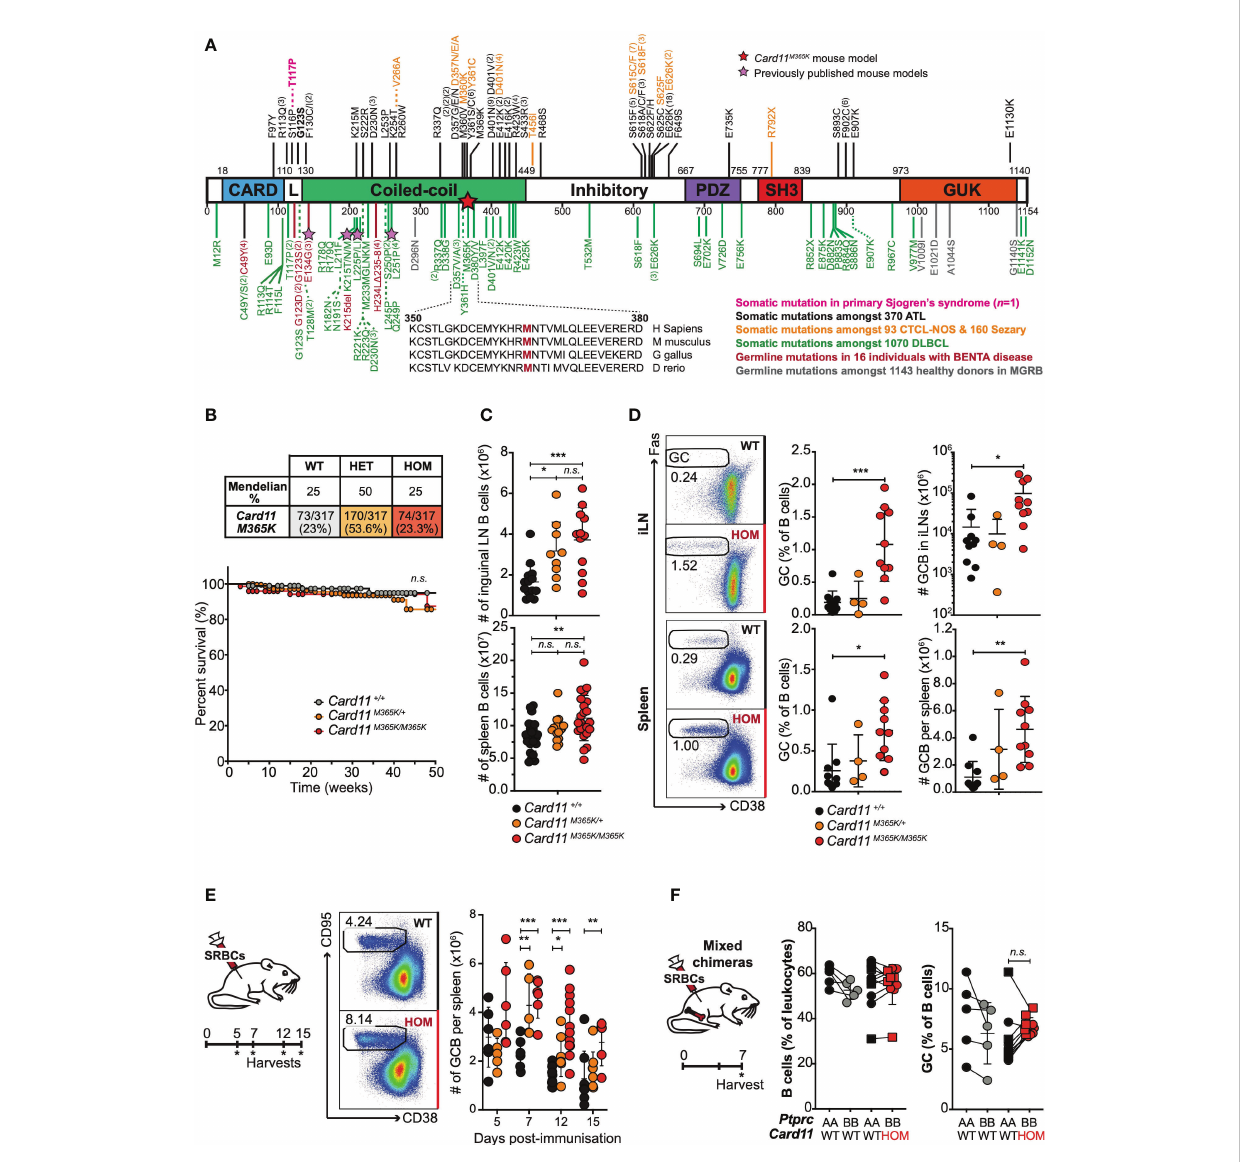
FIGURE 1 Gain-of-function Card11 M365K germline mutant mice have increased numbers of germinal center B cells. (A) . Schematic of CARD11 protein domains showing location of germline GOF mutations in healthy donors from the MGRB database (grey) or individuals with BENTA disease (red (23 – 29);), and somatic GOF mutations identi fi ed in adult T cell leukemia/lymphoma (ATL (38, 56 – 58); black), cutaneous T cell lymphoma not otherwise-speci fi ed (CTCL-NOS) or Sezary syndrome (orange (43 – 46, 59 – 61);), diffuse large B cell lymphoma (DLBCL (30, 31, 51, 62 – 64); green) or in one individual with primary Sjögren ’ s syndrome (pink (65);). Stars indicate the Card11 M365K or other, previously published (52 – 54), mouse models of CARD11 GOF. (B) . Top, Expected and observed numbers and percentages of offspring of the indicated genotypes from intercrossed heterozygous parents. Statistical testing for no difference relative to an expected 1WT:2HET:1HOM ratio p =0.4328 by Chi-Square test with n =2 degrees of freedom. Bottom, Kaplan-Meier survival curve for mice of the indicated genotypes, calculated using the product-limit method accounting for censored mice. (C) . Symbols denote total number of B cells in the inguinal lymph nodes (top) or spleen (bottom) from individual mice of the indicated genotypes. (D) . Left, Representative fl ow cytometric analysis showing the percentage of CD38 low CD95 + germinal center (GC) B cells gated on splenic B cells in non-immunized mice. Right, percentage or total number of GC B cells in the inguinal lymph nodes (iLN; top) or spleen (bottom) from mice of the indicated genotypes. (E) . Left: Schematic of experimental work fl ow. Middle: Representative fl ow cytometric analysis showing the percentage of GC B cells gated on splenic B cells in mice 7 days post-immunization with sheep red blood cells (SRBCs). Right: Total number per spleen of GC B cells 5, 7, 12 or 15 days post-SRBC immunization. (F) . Rag1 KO/KO Card11 +/+ mice were irradiated and reconstituted with Ptprc a/a Card11 +/+ (black fi ll) bone marrow in a 1:1 mixture with Ptprc b/b Card11 +/+ (grey fi ll) or Card11 M365K/M365K (red fi ll) bone marrow, and sacri fi ced 7 days post-SRBC immunization. Graphs show B cells as a percentage of Ptprc a/a or Ptprc b/b splenic leukocytes, or GC B cells as a percentage of Ptprc a/a or Ptprc b/b B cells, in mice that received bone marrow of the indicated genotypes. (C-E) . Statistical comparisons made by t -test, corrected for multiple comparisons using the Holm-Sidak method. Data are representative of n > 2 independent experiments with n > 5 mice per group. (E) . Data are pooled from 3 independent experiments. Comparison made after excluding the one high outlier. (F) . Statistical comparisons made by paired t -test. not signi fi cant (n.s) p > 0.05; * p < 0.05; ** p < 0.01; *** p <